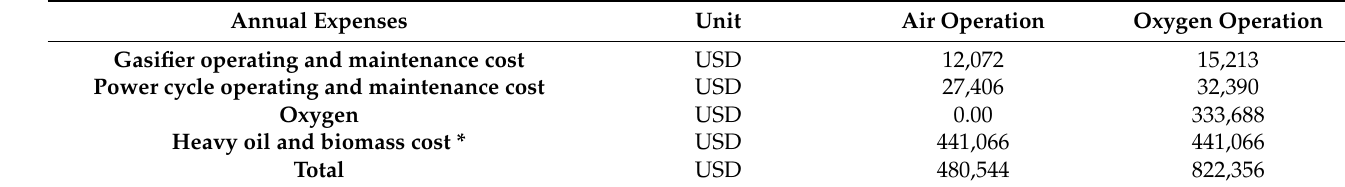
Table 11. Annual expenses of the power